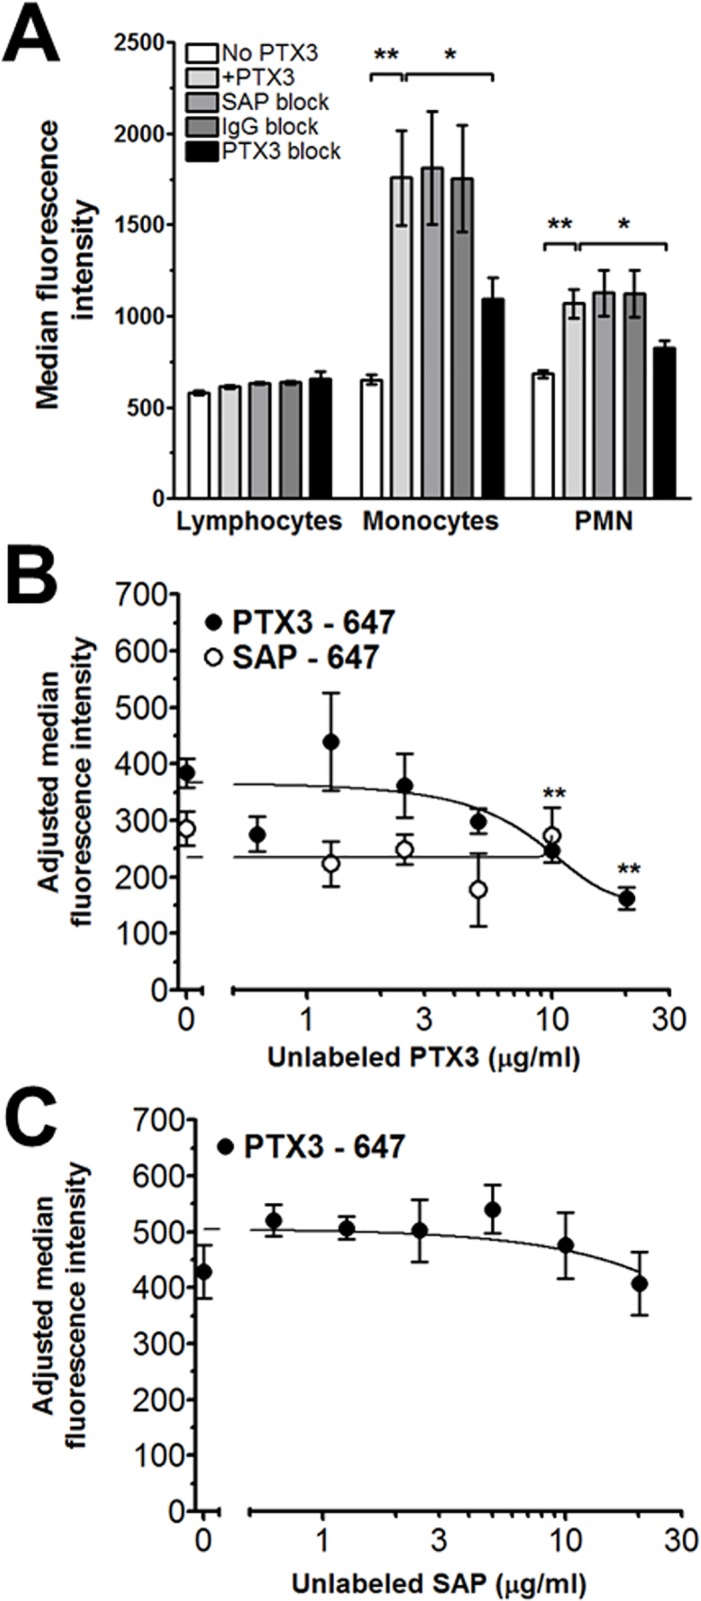
PTX3 and SAP bind to overlapping sites on leukocytes.A) Human Leukocytes were incubated with 1 μg/ml unlabeled PTX3, SAP, or human IgG Fc for 30 minutes at 4°C. Cells were then incubated with 1 μg/ml labelled PTX3, for an additional 30 minutes at 4°C. The cells were then washed, and the binding of the labeled PTX3 to the cells was measured by flow cytometry. Values are mean ± SEM, n = 5. * p <0.05, ** p <0.01 (ANOVA), compared to cells incubated with PTX3-647. HEK293 cells expressing FcγRI were incubated with B) PTX3-647 or SAP-647 in the presence of unlabeled PTX3, or C) PTX3-647 and unlabeled SAP. The cells were then washed, and the binding of the labeled pentraxin to the cells was measured by flow cytometry. Autofluorescence values were subtracted from the total binding values. Values are normalized mean ± SEM, n = 3. Lines are fits to models of one-site binding with variable Hill coefficient or linear regression. ** p <0.01 (t-test), compared to cells incubated with PTX3-647 alone.